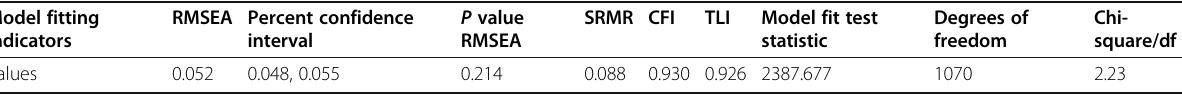
Table 5 Model fitting statistics using the R software to validate structural constructs Model fitting